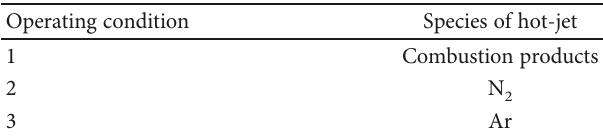
Table 5: Parameters used to describe operating condition in simulation.